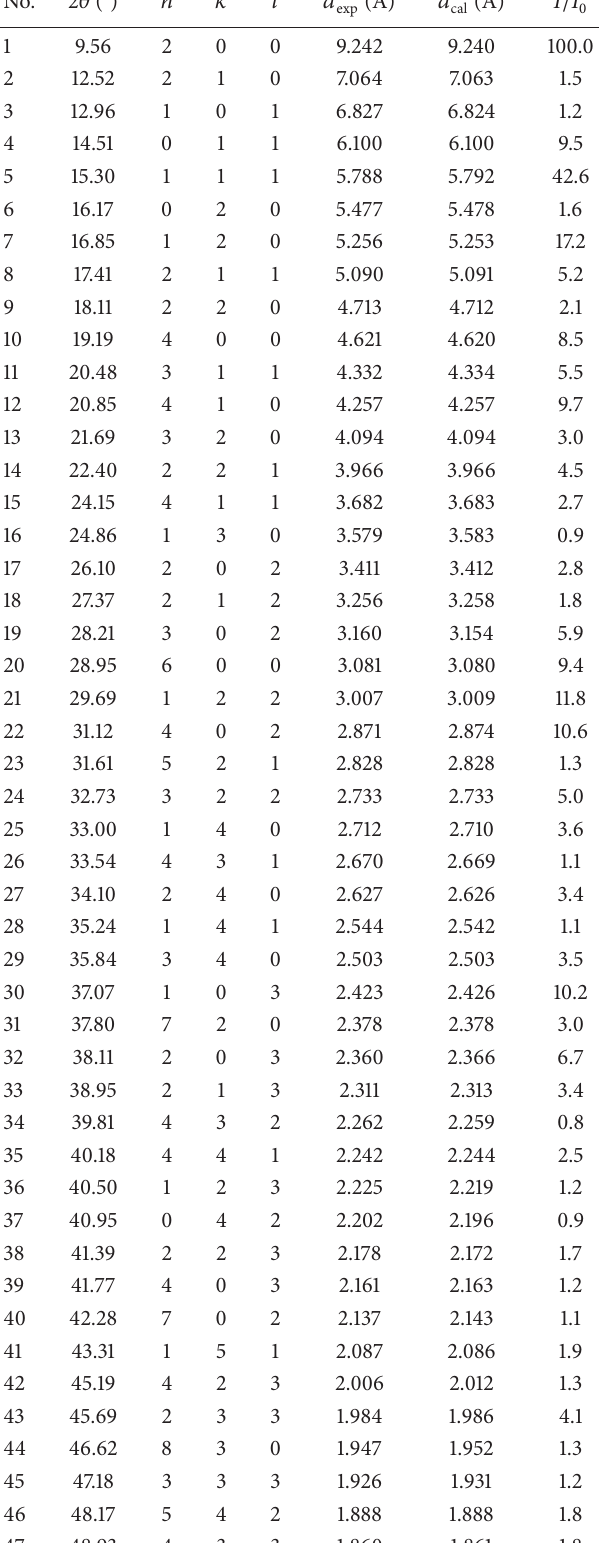
Table 4: Experimental data and calculated results for powder X-ray diffraction pattern of the complex [Sb(Hedta)] ⋅ 2H bic system: 𝑎 = 18.479 ˚A, 𝑏 = 10.957 ˚A, and 𝑐 = 7.343 ˚A).